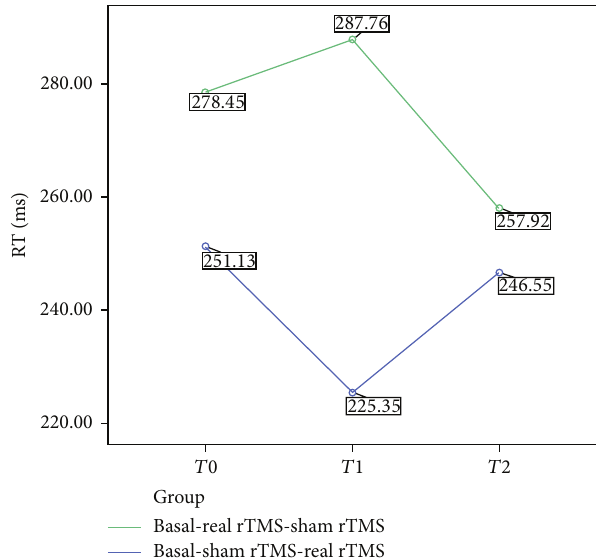
Figure 4: Trend of RTs for group 1 (basal, sham, and real) and group 2(basal,real,andsham)duringrepetitionofCNVtaskat T 0, T 1,and T 2